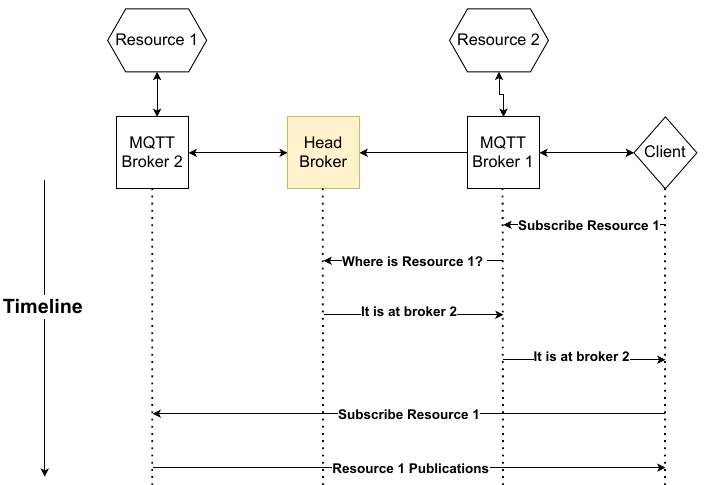
Figure 1. Illustration of architectures where the client is involved in the discovery